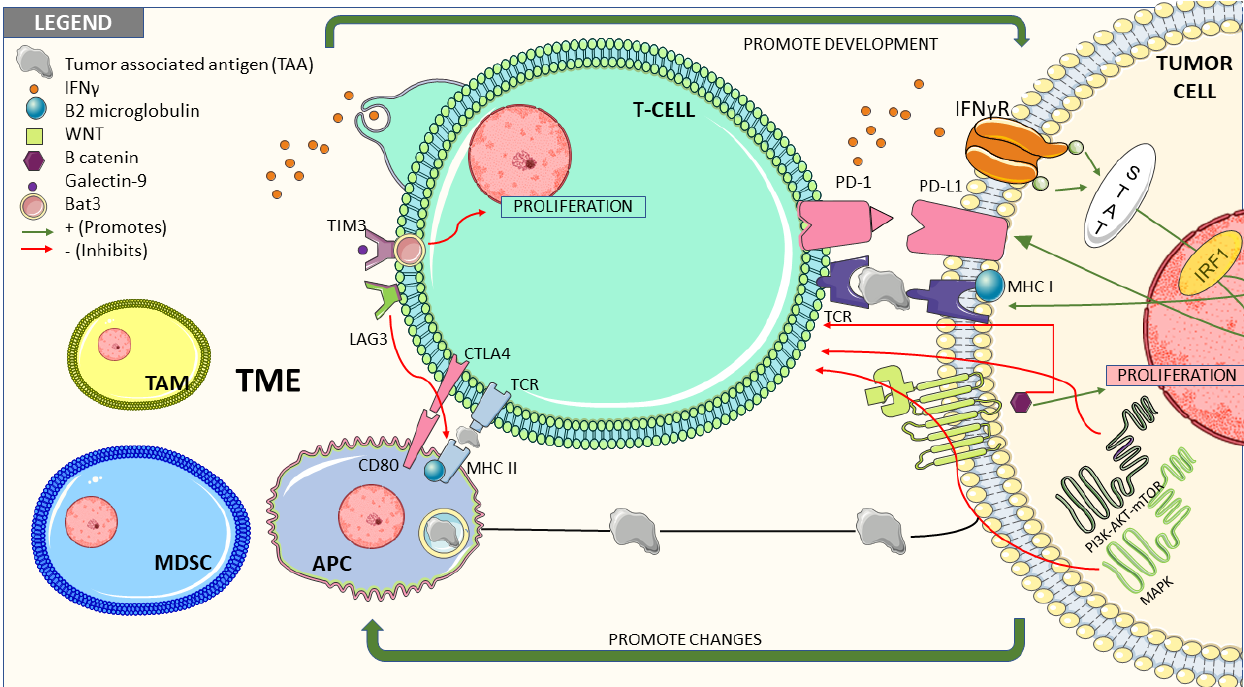
Figure 2. Among the key mechanisms described we can mainly distinguish tumor-intrinsic factors and factors associated to tumor microenvironment (TME). In the first subgroup it is important to outline the alterations of antitumor immune response pathways (e.g., aberrant expression of tumor antigens), variations in the antigen presentation pathways (e.g., β 2-microglobulin mutations leading to loss of MHC) or defective signaling pathways (e.g., IFN γ -STAT-IRF1 signaling pathway); What is more, these intrinsic factors promote the formation of an immunosuppressive microenvironment through the mutations of functional genes such as Wnt/β -catenin, MAPK, or PI3K-AKT-mTOR pathways and the modifications of the metabolism of TME (e.g., hypoxic conditions); The second subgroup (factors associated to TME) includes the presence of immunosuppressive cells (e.g., MDSCs or TAM) as well as the activation of coinhibitory receptors (e.g., TIM-3, LAG-3).